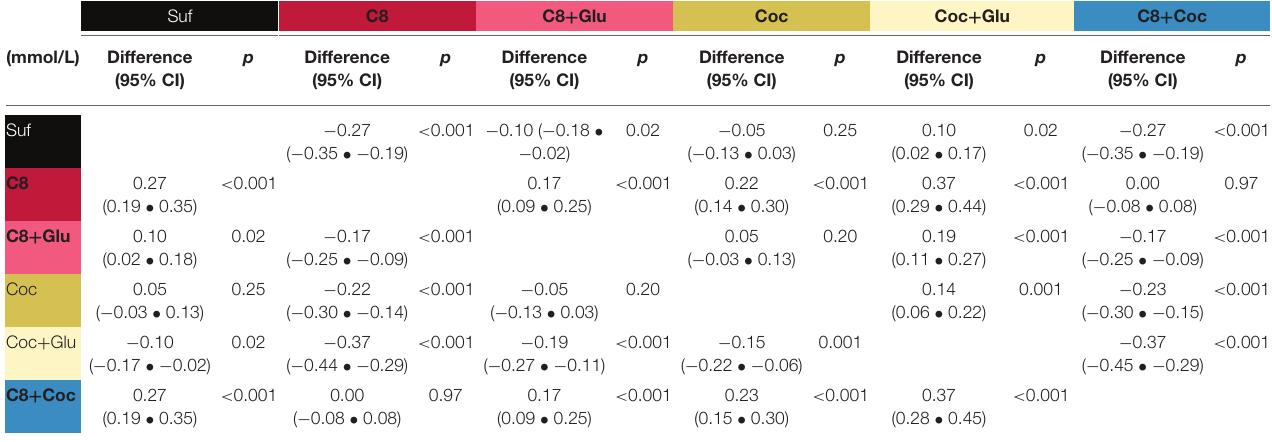
TABLE 3 | Differences (row-column) in BHBv (AUC/time) between arms during T0–T240 (minutes). Suf C8 C8 + Glu Coc Coc + Glu C8 + Coc (mmol/L)